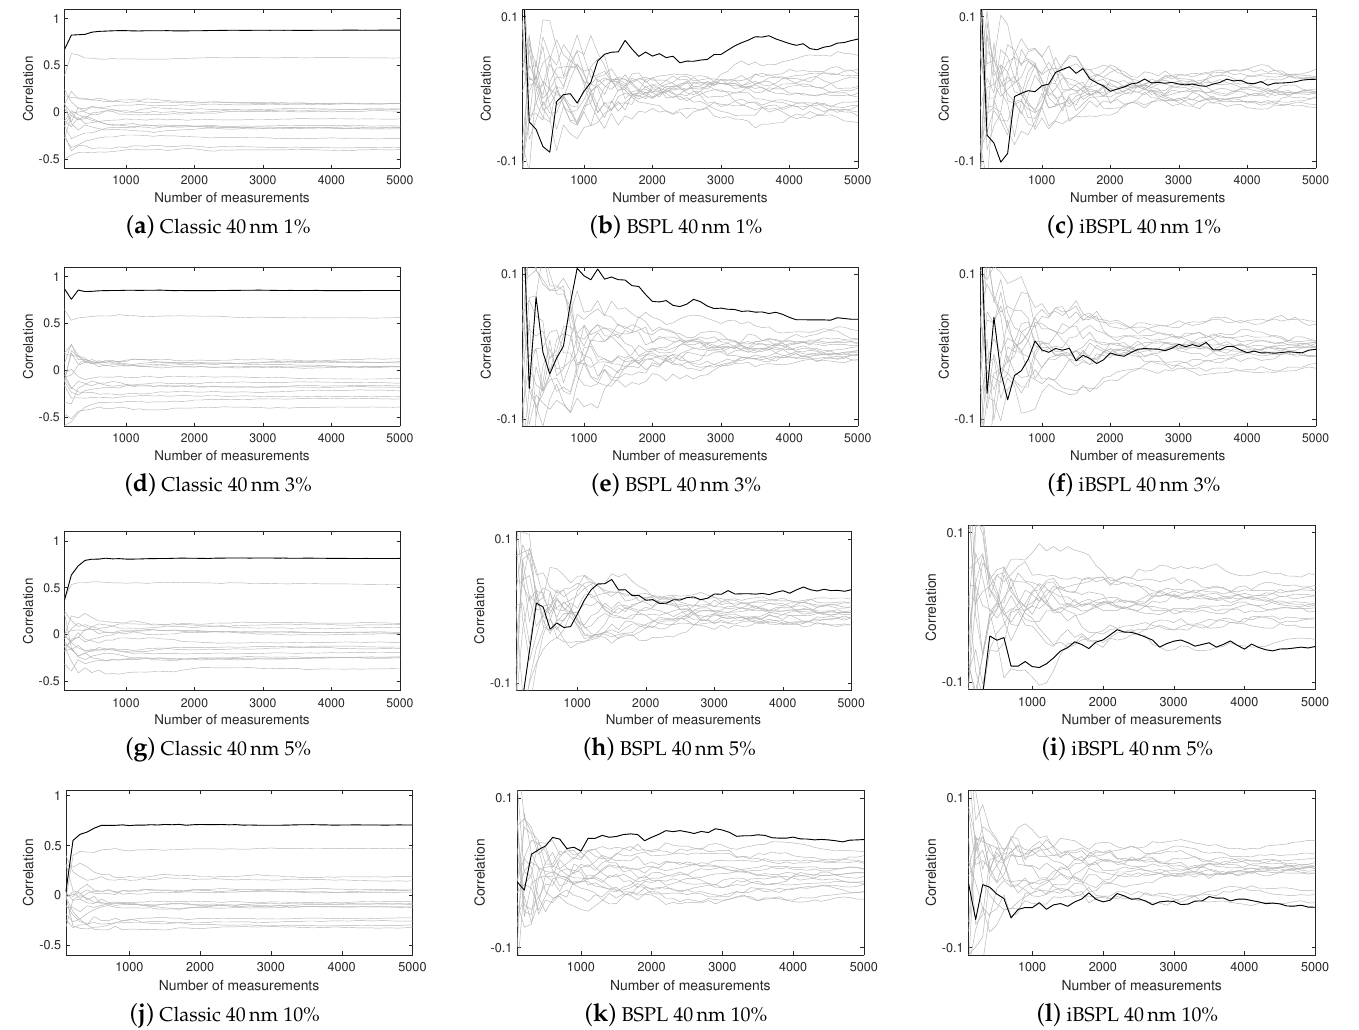
Figure 11. Average of 500 MCDPA attacks using 5000 simulations of noisy SBox leakage currents for random inputs modeling different levels of intra-die process variations (40nm).